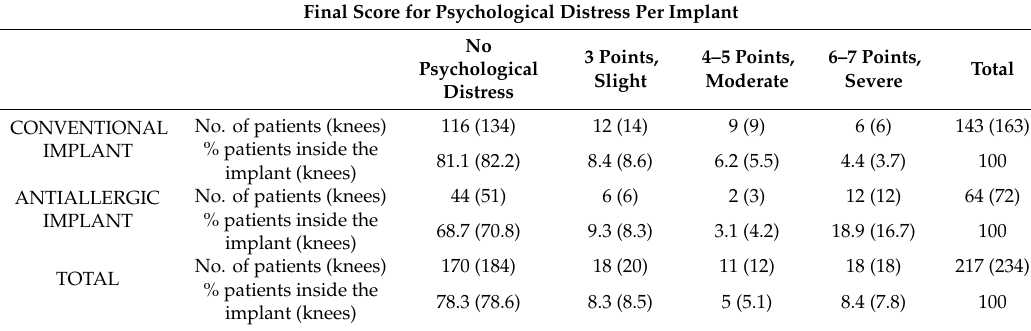
Descriptive characteristics of psychological distress according to conventional and hypoallergenic implant treatment. The results are presented as the total value and percentage.